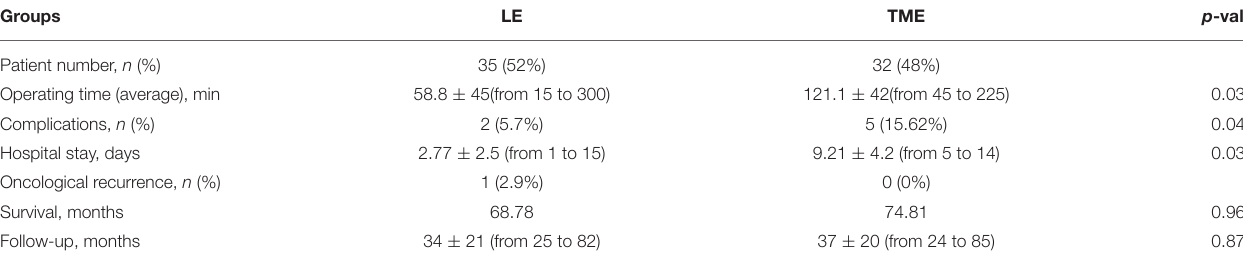
TABLE 2 | Comparison of two groups included in our study (LE, local excision group and TME, radical surgery group). Groups LE TME p -value